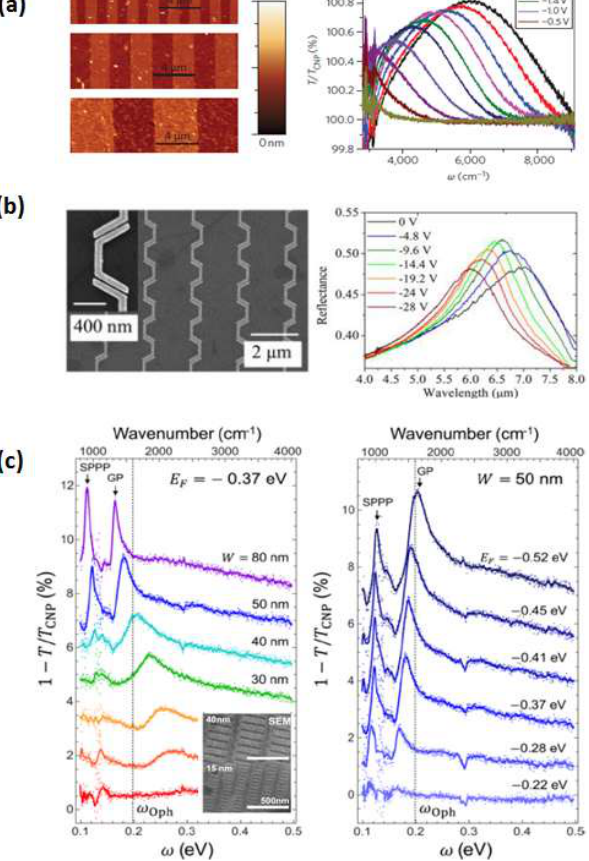
Figure 6: Left-to-right: (a) From [157]: Nanoribbons in graphene, demonstrating the observation of graphene localized surface plas- mon resonances in the THz regime. Resonances peaks (normal- ized to transmission through an ungated graphene layer at charge- neutrality point) are seen to tune with gate voltage. (b) From [164]: SEM image of gold waveguide antennae, with a slot size of 30